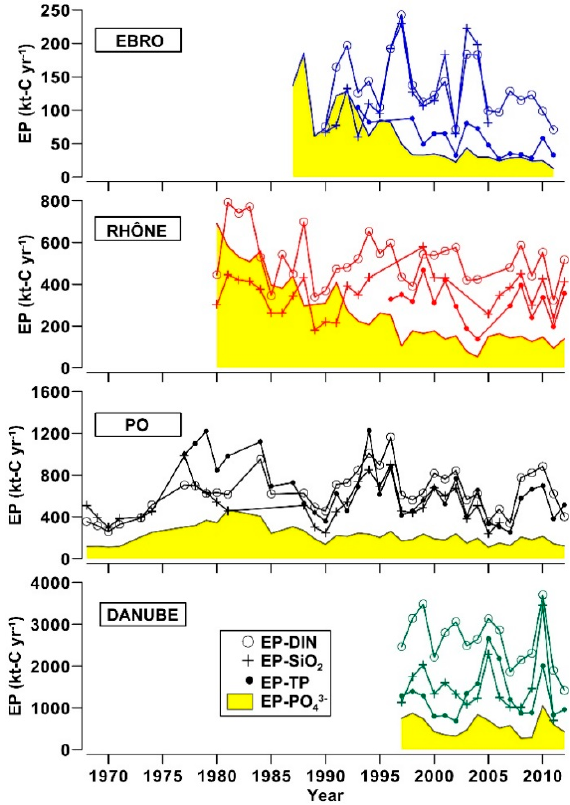
Figure 5. Eutrophication potential of river nutrient loads (EP; kt ‐ C yr − 1 ) estimated by Redfield’s model and annual river discharges of DIN, SiO 2 , TP and PO 43 − . For each year, the lowest value of EP identifies the nutrient that potentially limits the new production sustained by river loads.